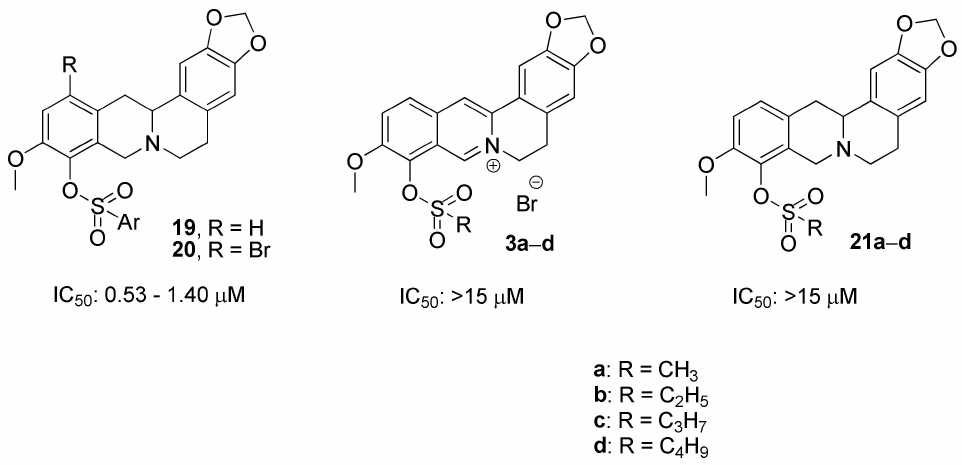
Figure 7. Previously synthesized berberine derivatives tested against